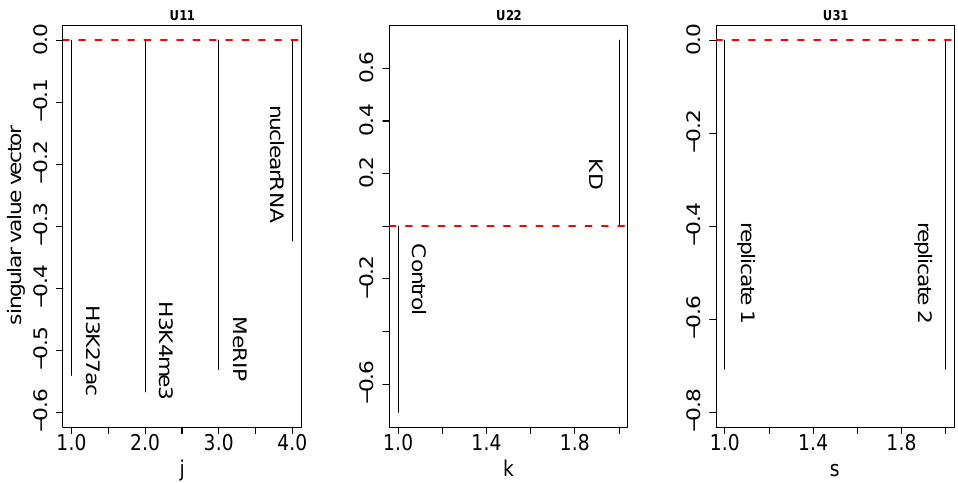
Figure 2. Singular value vectors obtained by applying HOSVD to HEC-1-A, x ijks . U11: u 1 j , U22: u 2 k , U31: u 1 s .